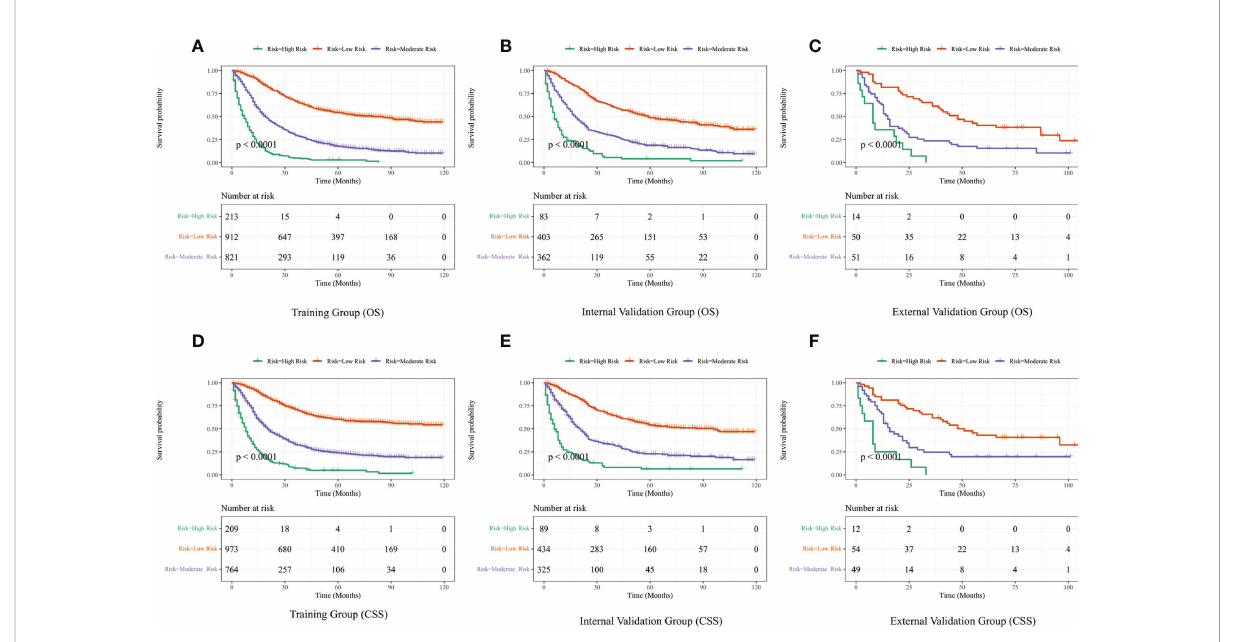
FIGURE 8 Performance of the nomograms in stratifying on the basis of risk points. (A) OS in the subgroups according to the risk strati fi cation in the training cohort. (B) OS in the subgroups according to the risk strati fi cation in the internal validation cohort. (C) OS in the subgroups according to the risk strati fi cation in the external validation cohort. (D) CSS in the subgroups according to the risk strati fi cation in the training cohort. (E) CSS in the subgroups according to the risk strati fi cation in the internal validation cohort. (F) CSS in the subgroups according to the risk strati fi cation in the external validation